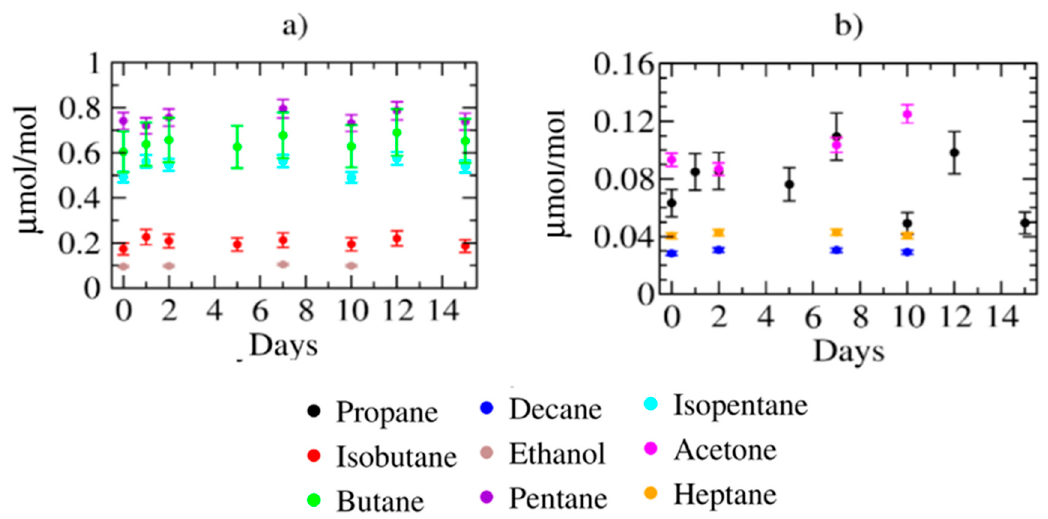
Figure 3. Storage stability of hydrocarbons on Tenax TA. ( a ) for isobutane, butane, ethanol, pentane and isopentane; ( b ) for propane, acetone, decane and heptane.